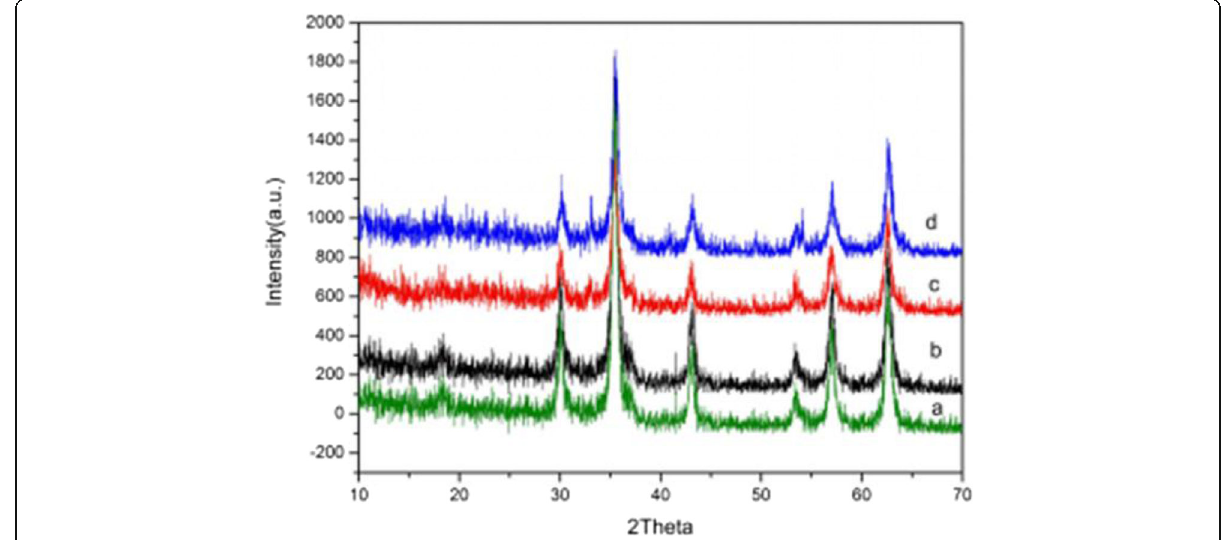
Fig. 5 XRD pattern of different amount of urea synthesized sample. a 6 mmol. b 8 mmol. c 10 mmol. d 15